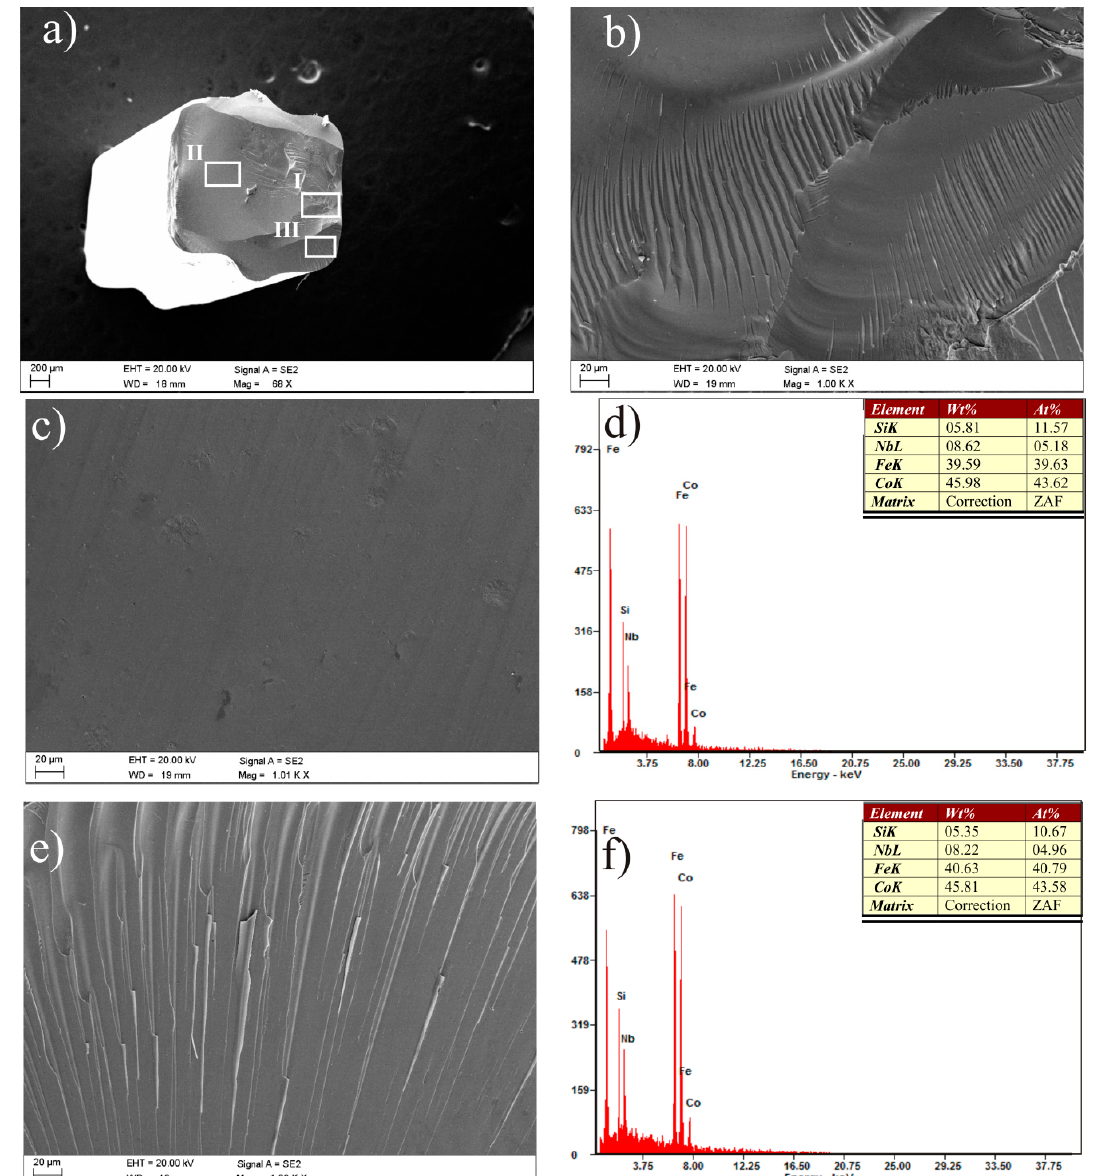
Figure 12. SEM micrographs of the fracture morphology of the Fe 35.75 Co 35.75 B 18.90 Si 5 Nb 4 Cu 0.6 rod with the diameter of 1.5 mm; ( a ) main view; ( b ) image of fragment I marked in (a) at higher magnification; ( c ) image of fragment II marked in (a) at higher magnification; ( d ) EDS spectrum from area in (c); ( e ) image of fragment III marked in (a) at higher magnification; ( f ) EDS spectrum from area in (e).